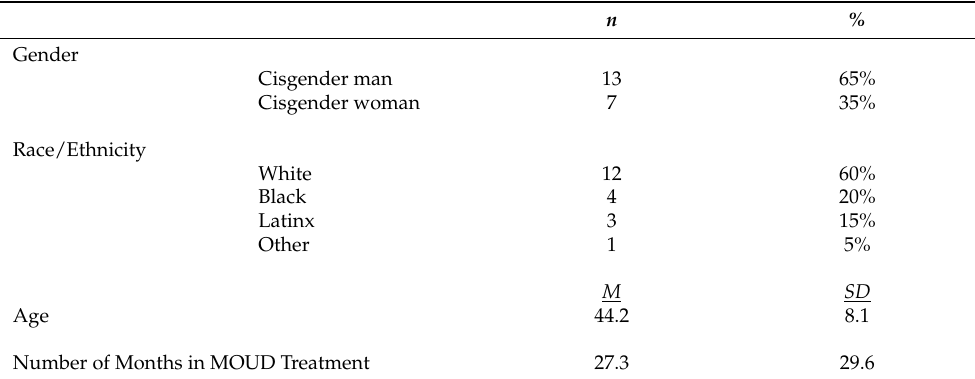
Table 1. Sample demographic and clinical characteristics ( n =